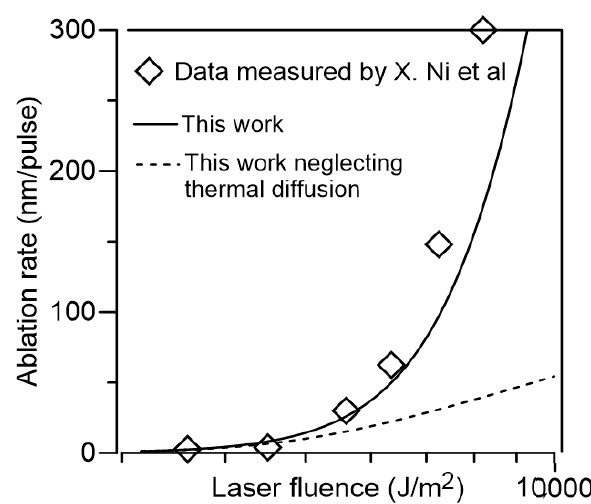
Figure 4. Variation of ablation rate with laser fluence for the solid line calculated by this work, the diamond symbols measured by the published paper [25], and the dashed line predicted by this work without considering thermal diffusion.